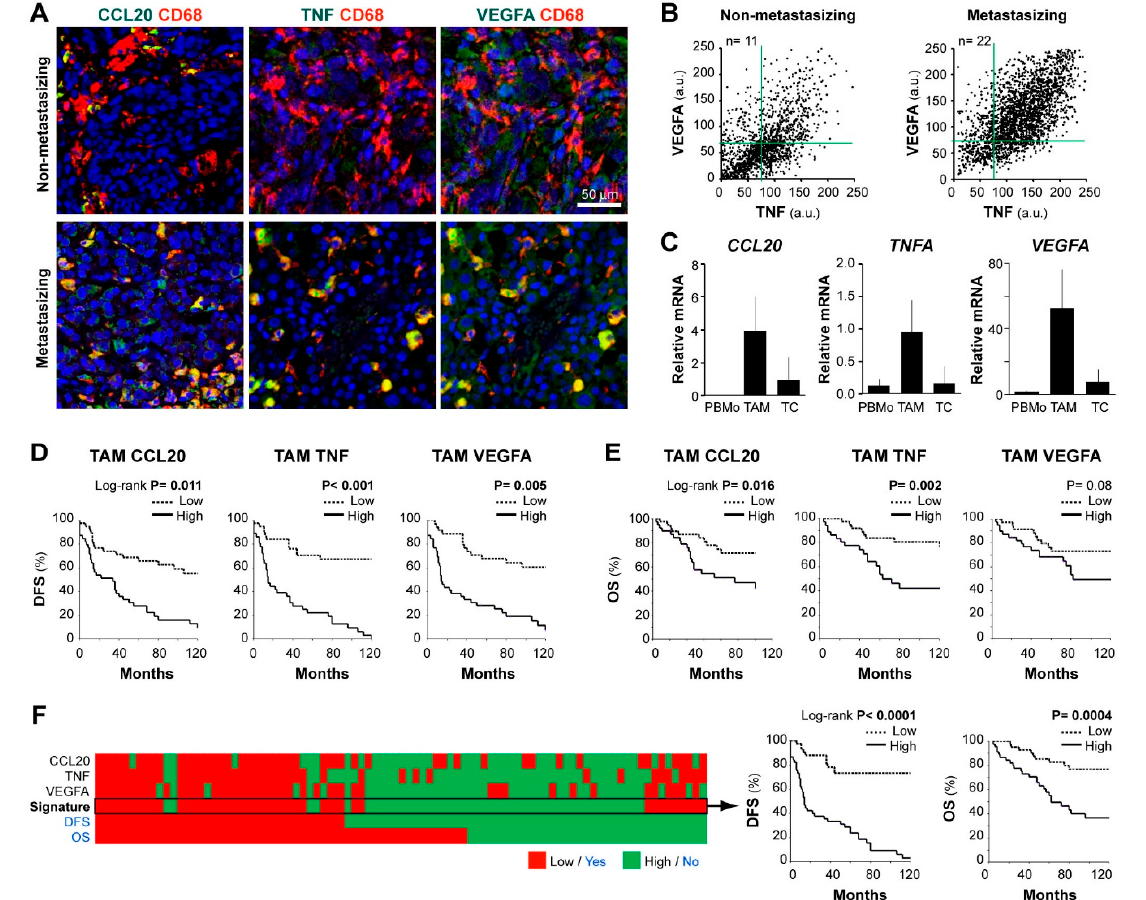
Figure 2. CCL20, TNF, and VEGFA expression in human melanoma TAMs and correlation with patient survival. ( A ) FFPE human melanoma samples co-stained for CD68 (TAM marker, red) and CCL20, TNF, or VEGFA (protumoral markers, green), as indicated. Representative images of non-metastasizing and metastasizing primary melanomas are shown. Scale bar, 50 μ m. ( B ) Dot-plots showing CD68+TAMs from non-metastasizing ( n = 11 samples; 1100 TAMs) and metastasizing ( n = 22 samples; 2200 TAMs) primary melanomas. ( C ) Expression of CCL20 , TNFA , and VEGFA mRNA (relative to average TBP/HPRT1 ) in freshly isolated peripheral blood monocytes CD14 + (PBMo), CD14 + TAMs, and negatively selected cells (CD14 − CD3 − ) from three-stage IV primary melanoma patients. ( D , E ) Correlation between patient evolution and TAM expression of CCL20, TNF, and VEGFA proteins. Disease-free ( D ) and overall ( E ) survival 10-year Kaplan–Meier curves are shown. Median values of the 83 primary melanomas were used to classify as ‘low’ or ‘high’ expressing samples. P values are shown (Log-rank). ( F ) Kaplan–Meier curves using CCL20/TNF/VEGFA as a whole signature (classified as ‘high’ or ‘low’ by majority: ≥ 2/3). DFS, disease-free survival. OS, overall survival.